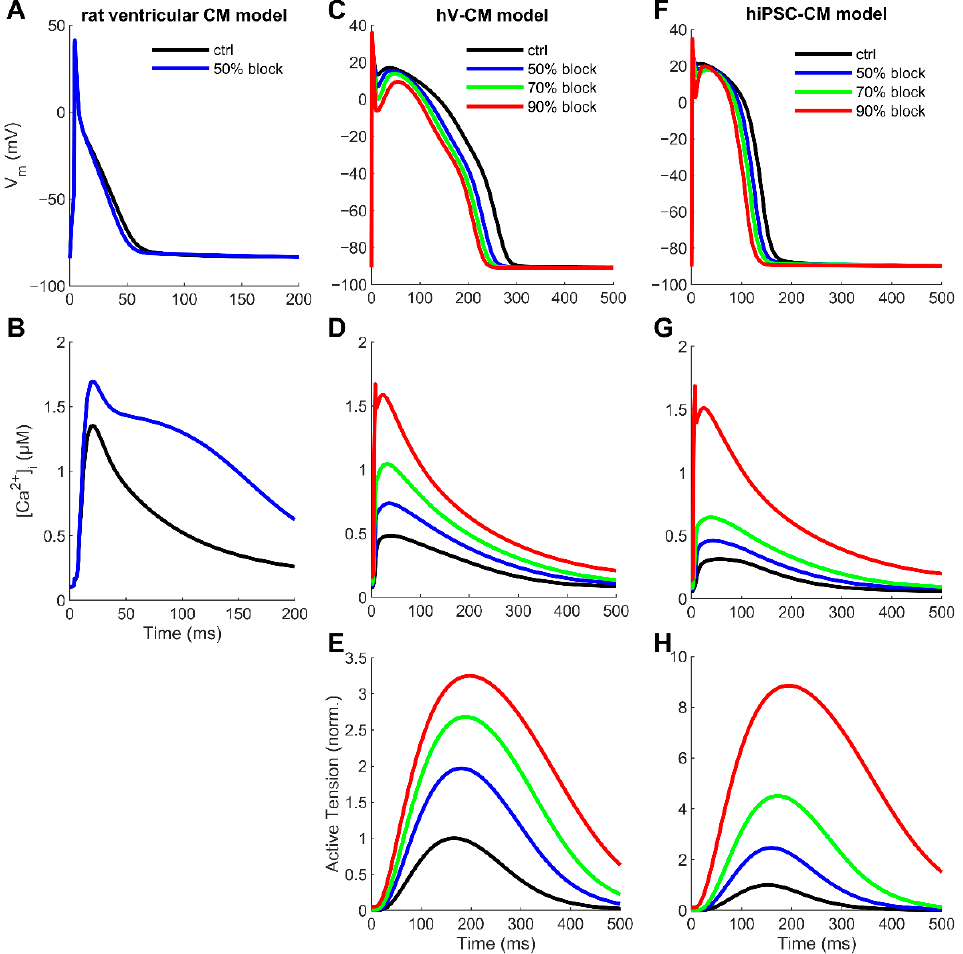
Figure 4. Simulated effect of NCX block in the rat ventricular, human ventricular, and hiPSC cardiomyocyte models. The principal outputs: membrane voltage ( A , C , F ), calcium transient ( B , D , G ), and active tension ( E , H ) with different degrees of NCX block. For details of the used models and simulation protocols, please see the Methods section.